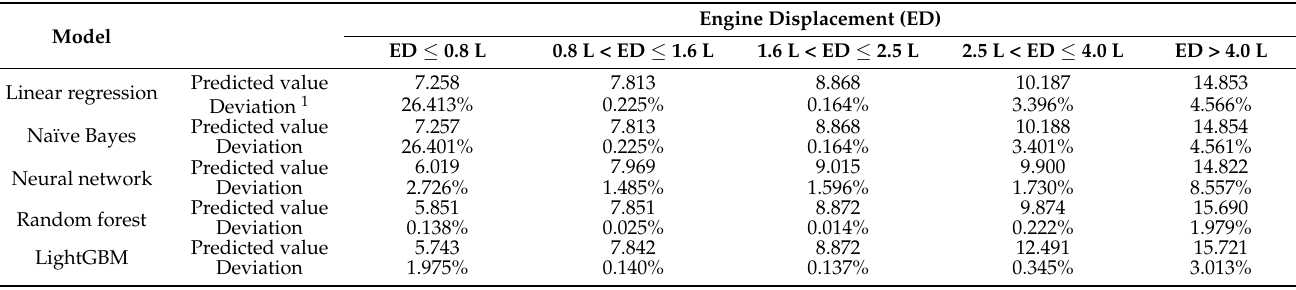
Table 8. Average predicted results.